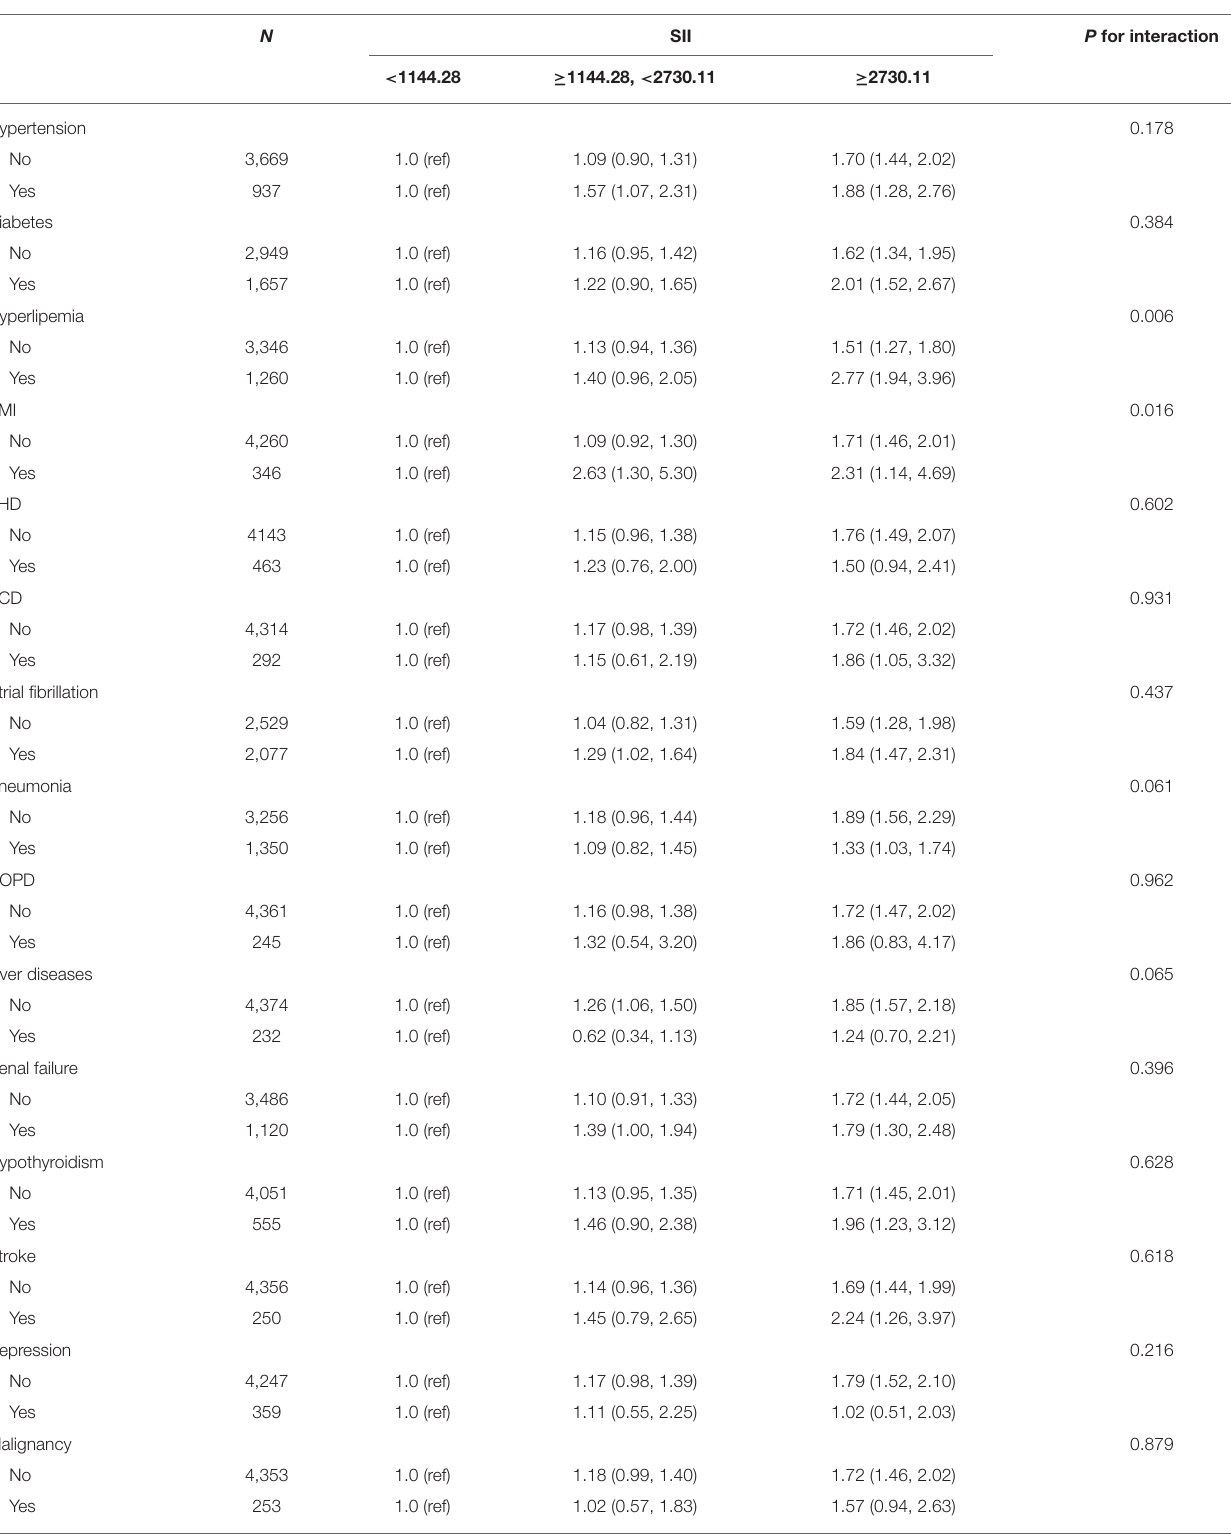
TABLE 4 | Subgroup analysis of the relationship between SII and 30-day all-cause mortality. N SII P for interaction < 1144.28 ≥ 1144.28, < 2730.11 ≥